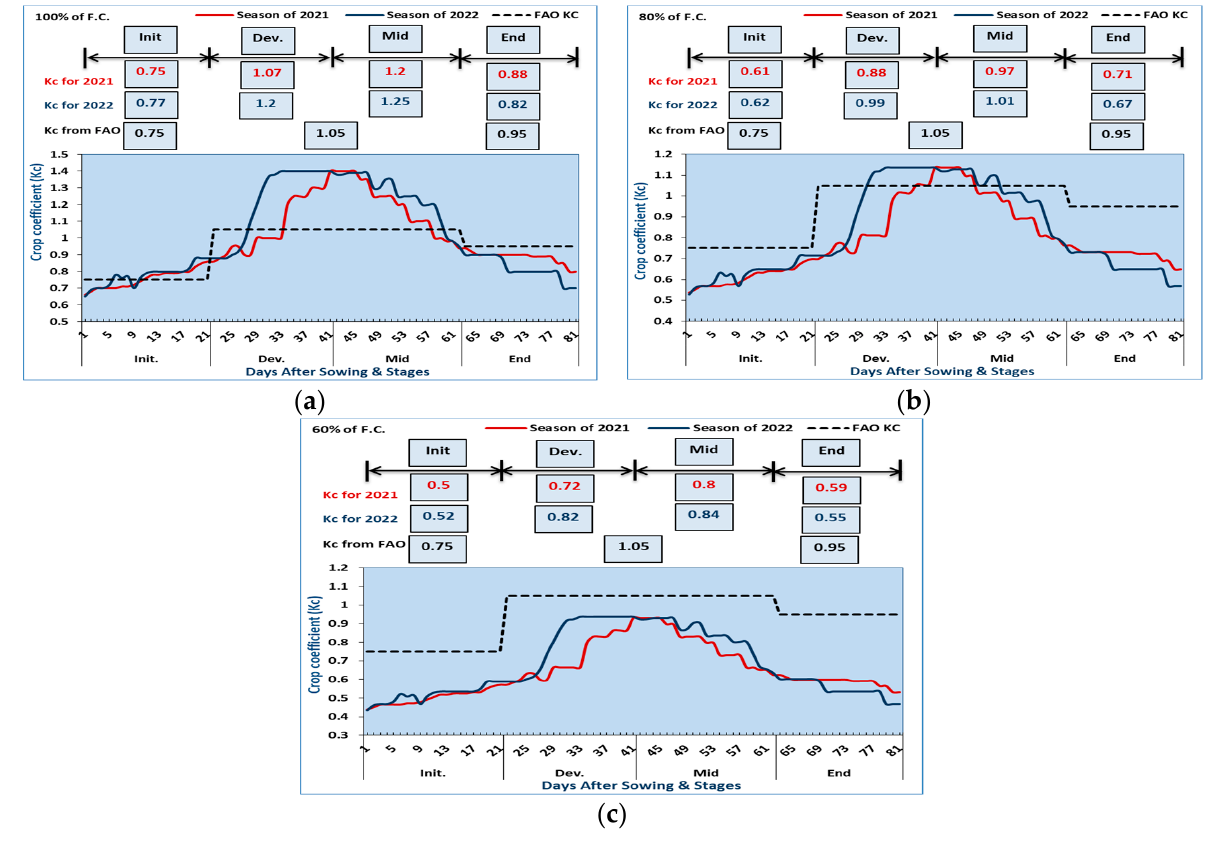
Figure 4. ( a – c ) . Crop coefficient (Kc) estimation for red cabbage crop at 100, 80, and 60% of (FC) for the 2021 and 2022 growing